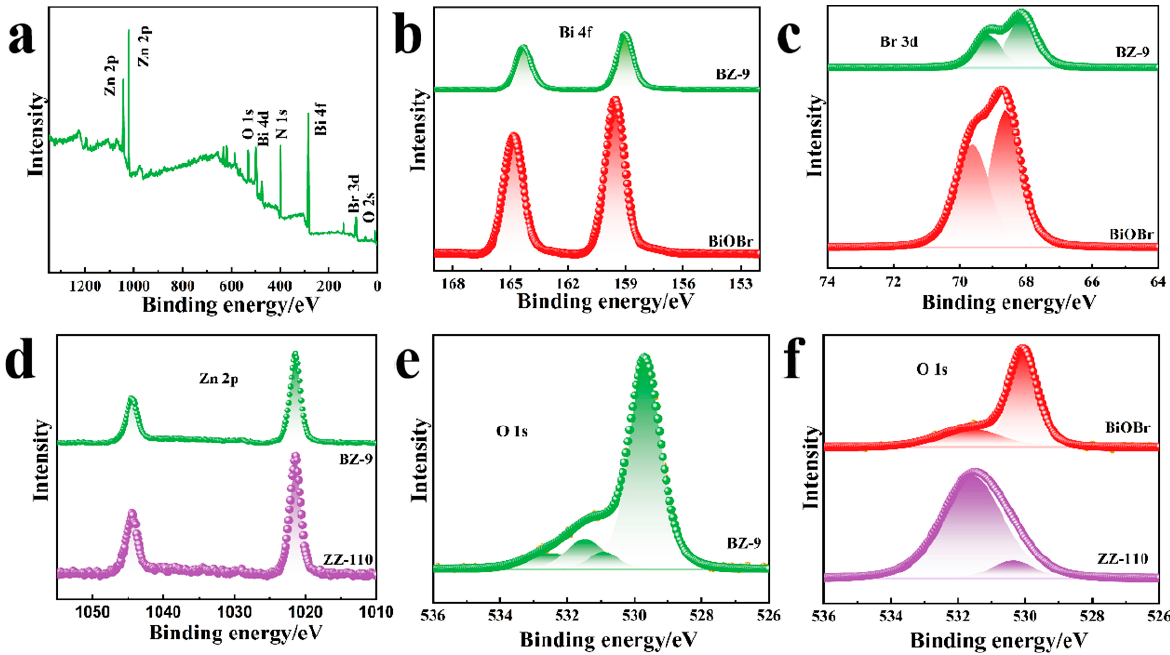
Figure 3. Full spectrum of BZ − 9 ( a ); Characteristic spectra of Bi 4f ( b ); Br 3d ( c ); Zn 2p ( d ); and O 1s ( e , f ).